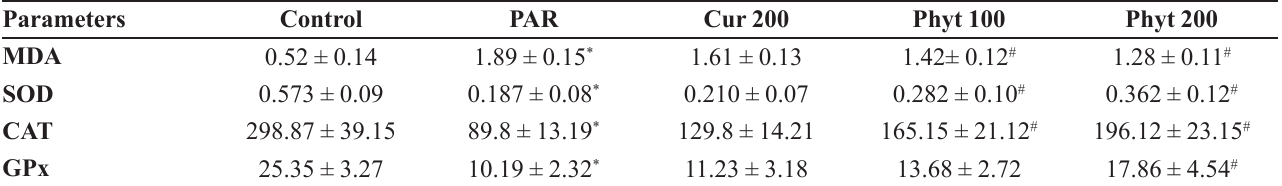
TABLE V - The effect of administration of phytosome curcumin on lipid peroxidation and antioxidant enzymes in mice liver tissue